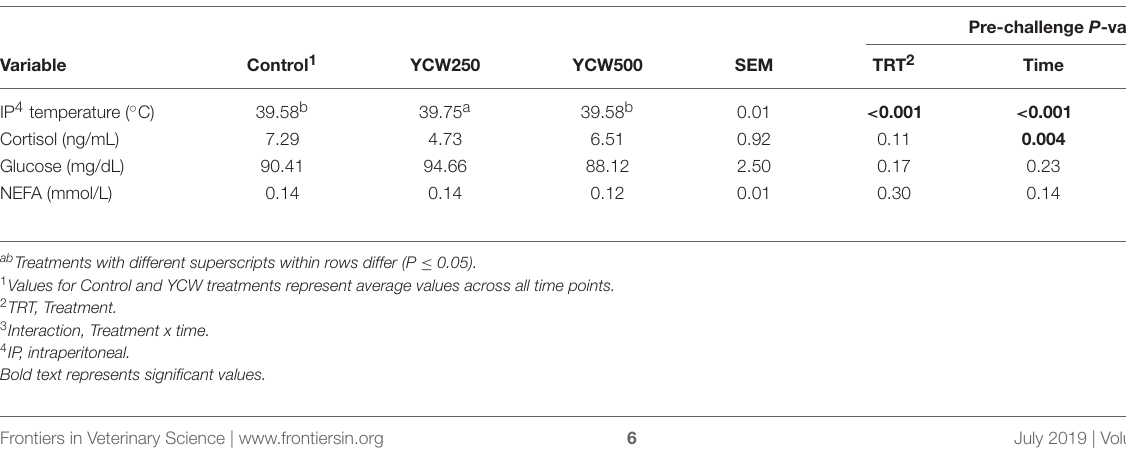
TABLE 2 | Intraperitoneal temperature and serum cortisol, glucose and non-esterified fatty acid (NEFA) concentrations measured in pigs fed a control (Control) diet or supplemented with a yeast cell wall at 250 mg/kg (YCW250) or 500 mg/kg (YCW500), prior to administration of an oral Salmonella Typhimurium challenge on d